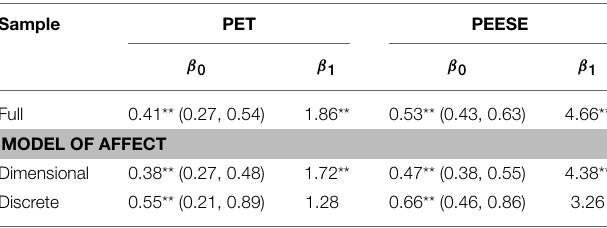
TABLE 4 | Results from PET-PEESE indicator based on Stanley and Doucouliagos (2014) approximation to reduce publication selection bias.